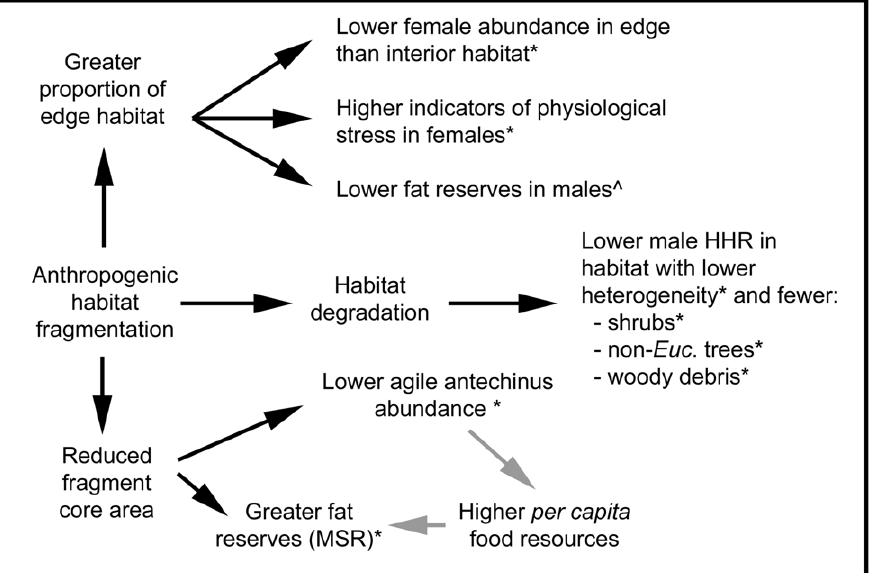
Figure 4. Conceptual flow diagram of the main results. There are well established associations between anthropogenic habitat fragmentation and the creation of novel edge habitat, habitat change and habitat area reduction [3]. Associations supported by significant findings are indicated by *. Findings that are significant, but may be confounded by an interaction, are indicated by ‘ . Grey arrows indicate a theoretical mechanism by which an association could be